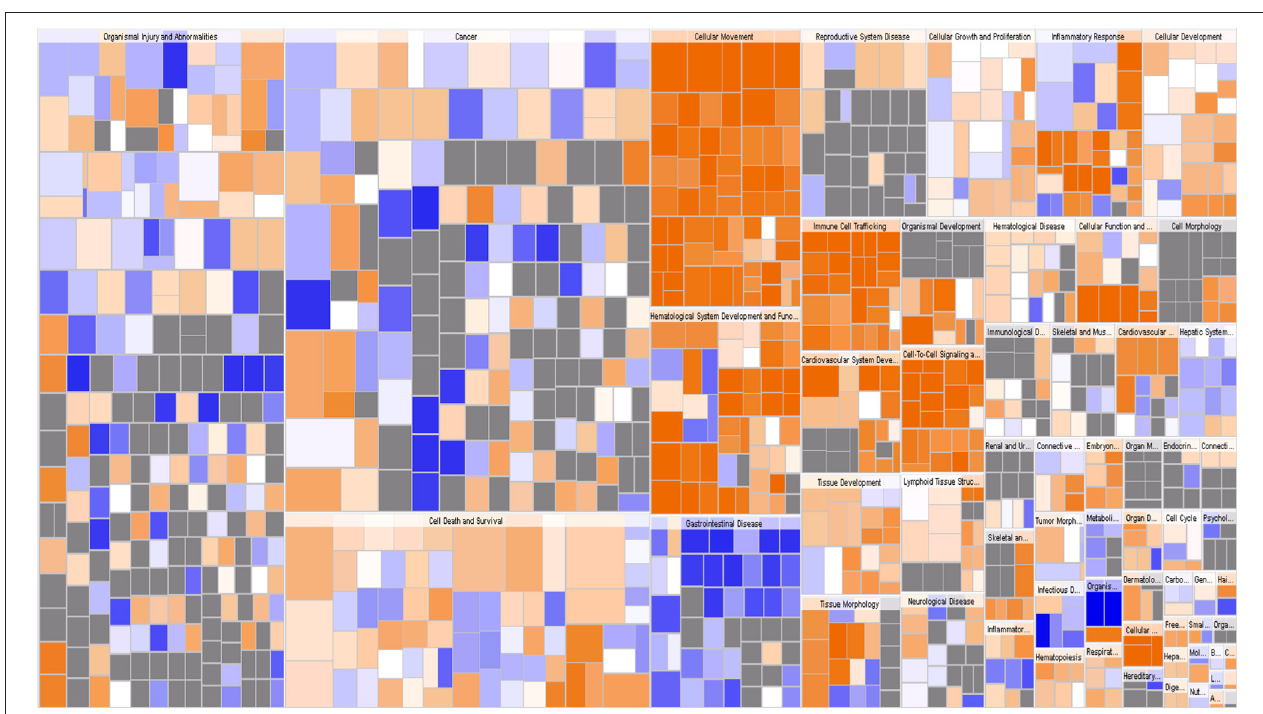
FIGURE 5 | Disease and function heat map. This figure demonstrates the relationships between changes in differentially expressed gene levels and the activation and inhibition of diseases and functions. Orange indicates that the disease or functional status is activated ( z -score > 0), blue indicates that the disease or functional status is suppressed ( z -score < 0), and gray indicates that the disease or functional status was not determined ( z -score cannot be calculated). TABLE 2 | Comparison of the upstream regulators of IARS2. Upstream